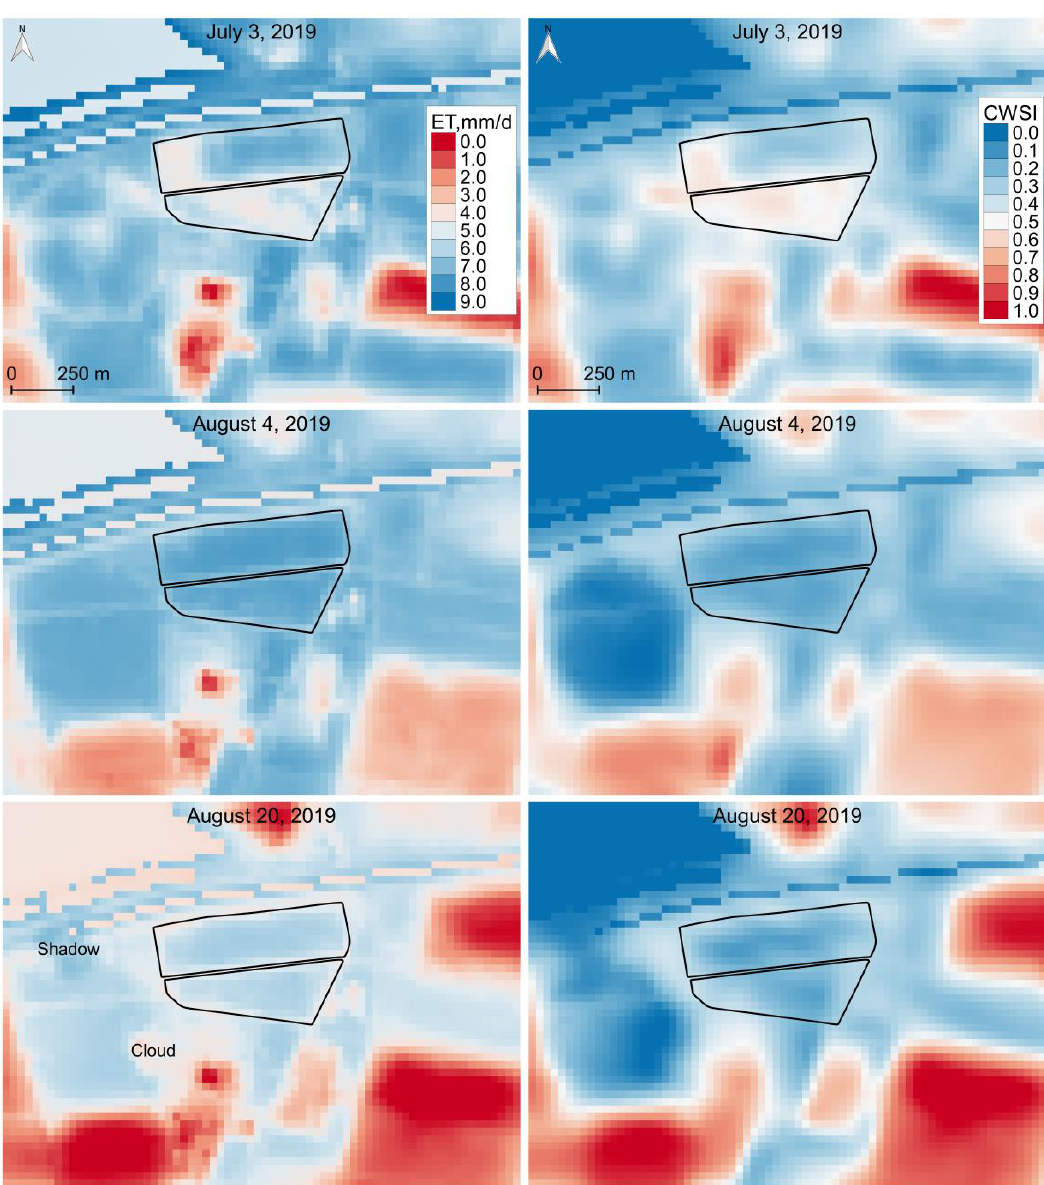
Figure 10. Evapotranspiration and water stress maps at and around the survey field on date 3 July, 4 August, and 20 August obtained from Surface Energy Balance Algorithm for Land (SEBAL) using temperatures derived from SB method.